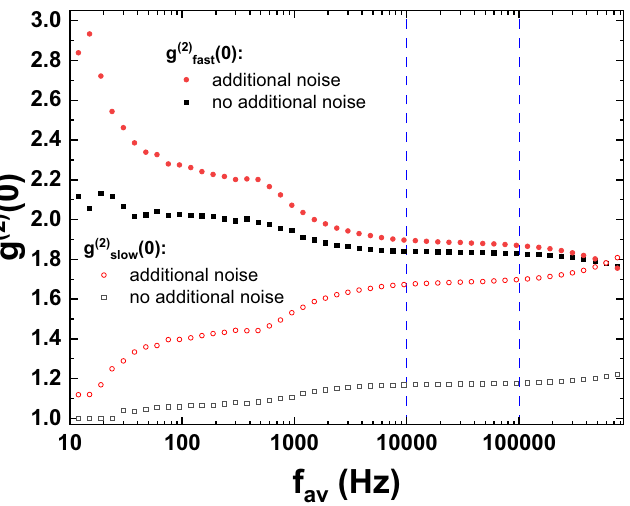
Figure 4. Photon correlation function of a polariton condensate operated at threshold versus averaging ( 2 ) ( 0 ) , which corresponds to noise contributions at frequencies above f av , frequency f av . Full symbols denote g fast ( 2 ) ( 0 ) , which corresponds to noise contributions at frequencies below f av . Results while open symbols denote g slow for standard operation and operation in the presence of additional mechanical noise are